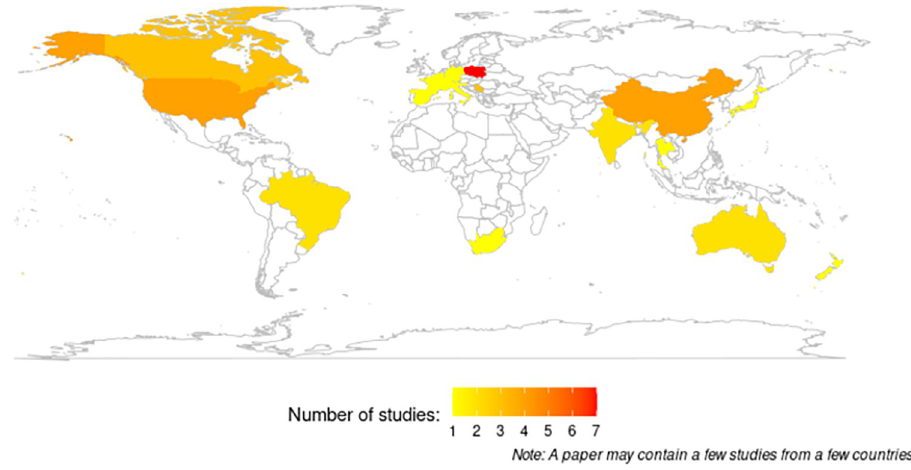
Fig 2. Distribution of selected studies by